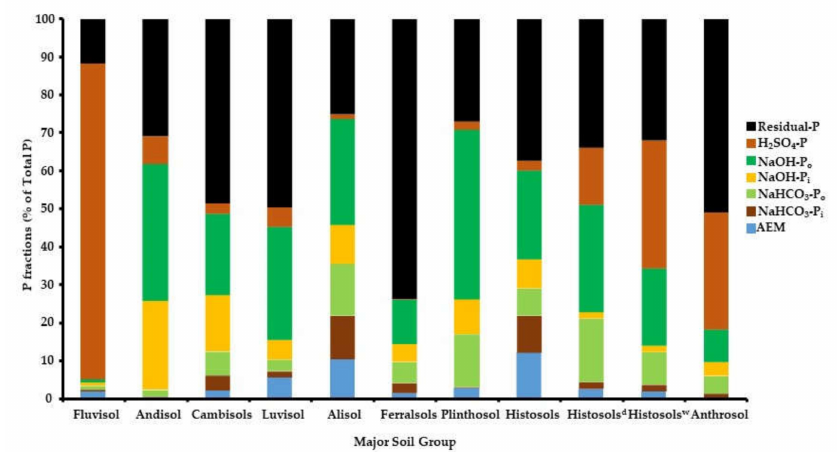
Figure 4. Proportions of di ff erent P fractions in some major soil groups and the present study (Histosols d and Histosls w ). Some of the major groups were the means of more than two studies. Data compiled for this figure derived from the control of each study with no manure and fertilizer application in the reported study if any. We summed to residual any P fraction determined after the fourth P fraction i.e., after 1 M HCl or 1 M H 2 SO 4 extraction. Histosols d and Histosls w : means of the three drained and three rewetted peatlands of the present study, respectively. Sources: